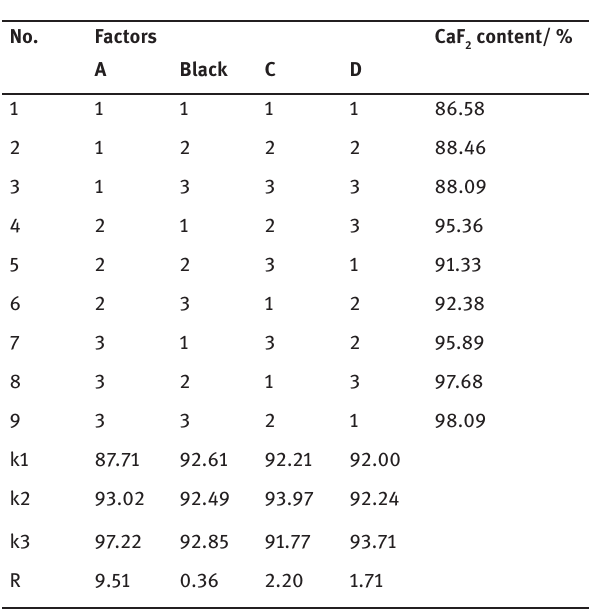
Table 3: Orthogonal text results.